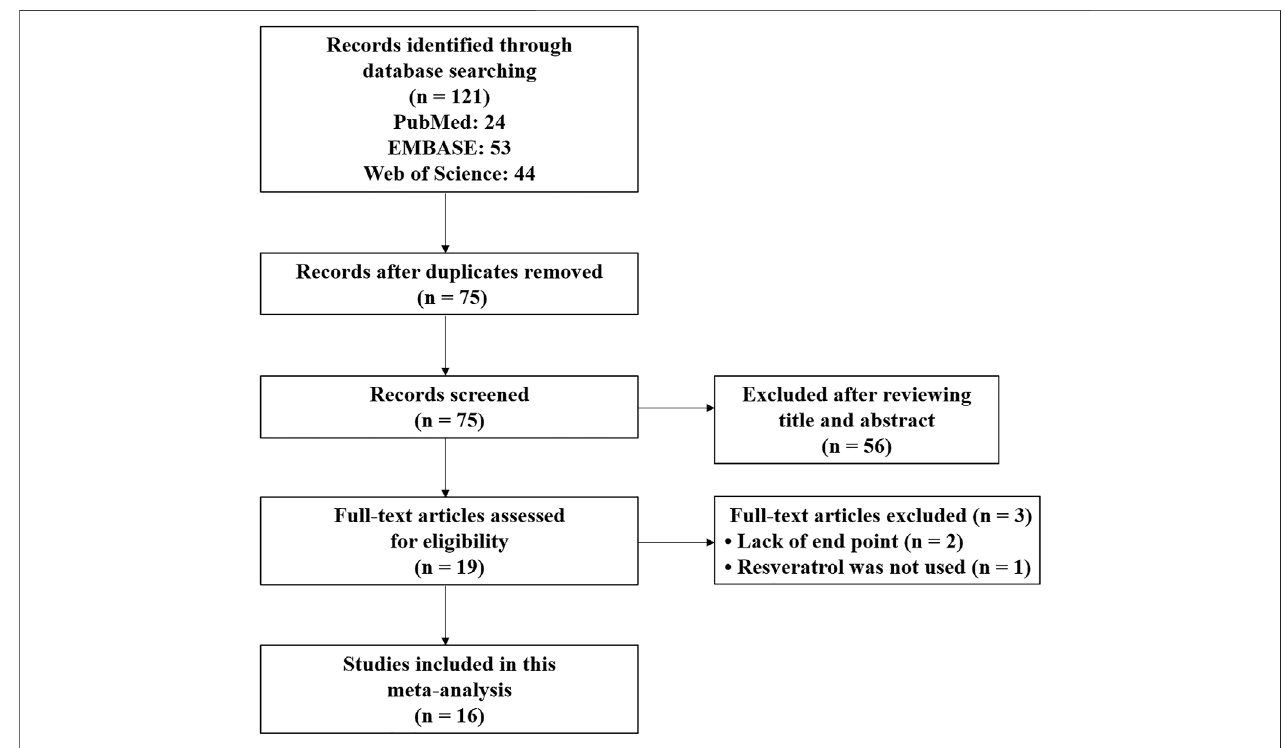
FIGURE 1 | Flowchart of the literature search